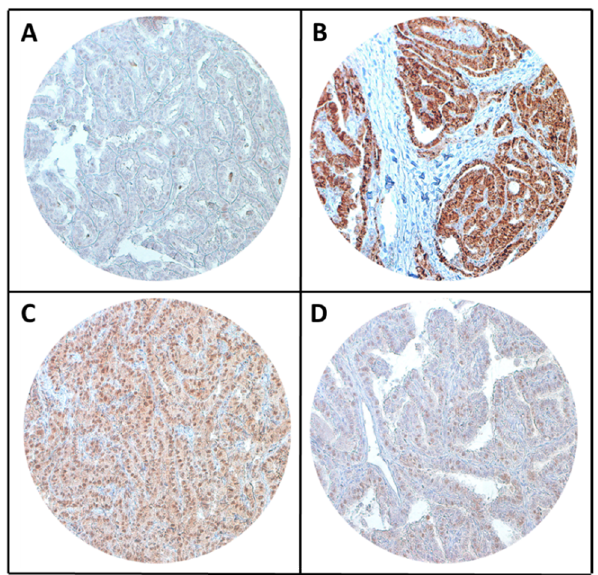
Figure 1. Tissue microarray (TMA)-based immunohistochemistry analysis of ZNF677 and phospho- AKT in papillary thyroid carcinoma (PTC) patients. PTC TMA spots showing loss of ZNF677 ( A ) and low expression of phospho-AKT ( D ). In contrast, another set of TMA spots shows normal expression of ZNF677 ( B ) and high expression of phospho-AKT ( C ). 20 X/0.70 objective on an Olympus BX 51 microscope. (Olympus America Inc., Center Valley, PA, USA).